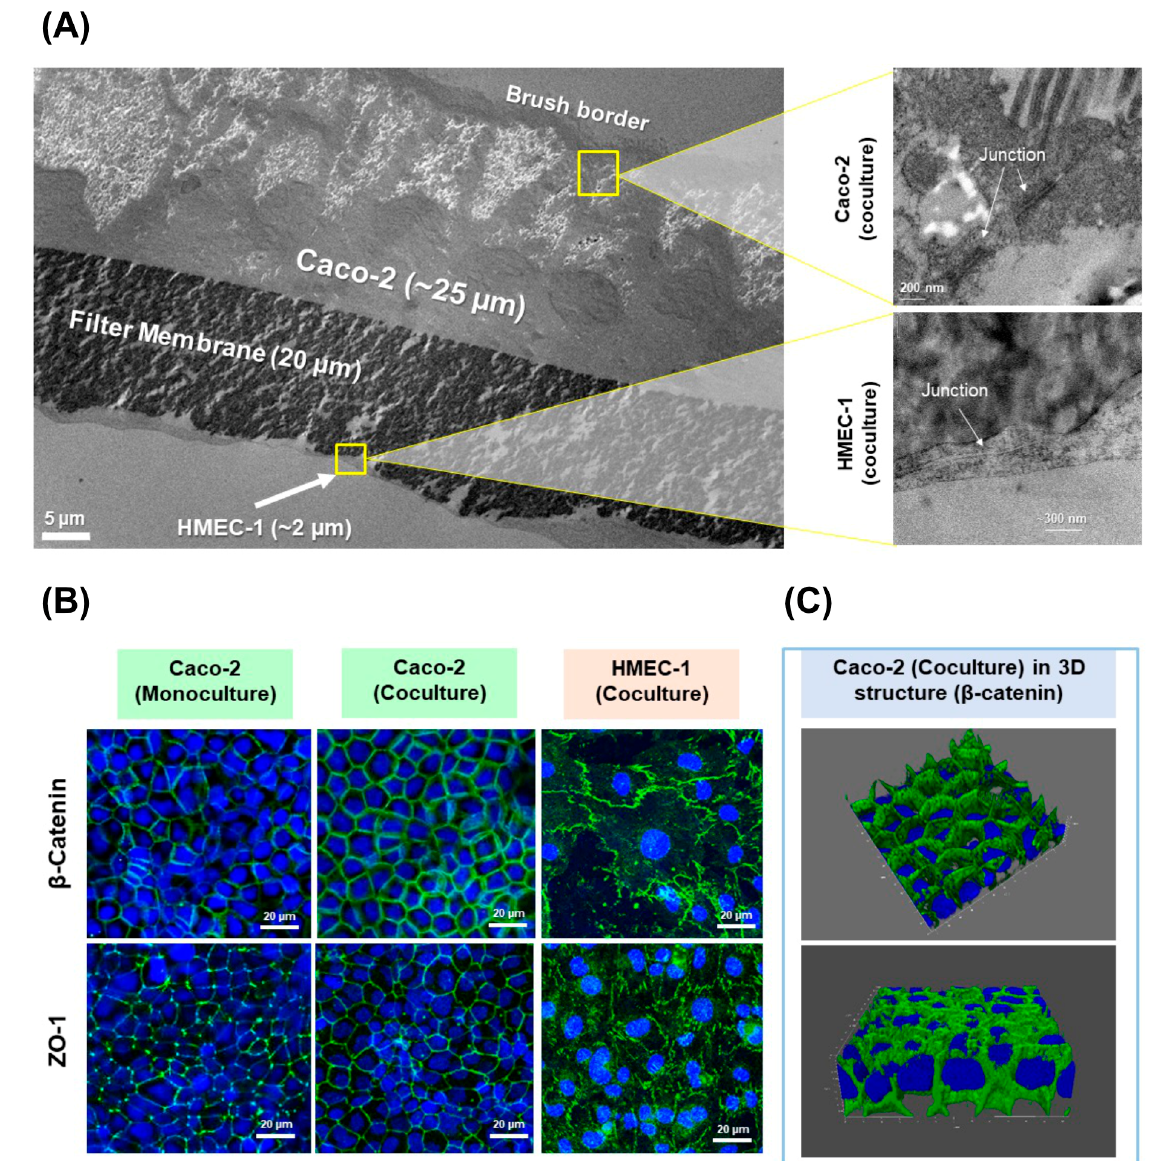
Figure 1. ( A ) Cross-sectioning images of Caco-2 and HMEC-1 coculture layers under TEM (left) and zoomed cross-sectioning images of the junction area between Caco-2 cells (upper right) and HMEC-1 cells (lower right); ( B ) immunofluorescent staining images of Caco-2 monoculture, cocultured Caco-2 and cocultured HMEC-1 layers, characterized by confocal microscopy for the expression of tight junction protein ZO-1 (Alexa Fluor ® 488, green) and adherens junction protein β -catenin (Alexa Fluor ® 488, green). The images are overlayed with cell nuclei (DAPI, blue); ( C ) the 3D images show only the expression of β -catenin in the cocultured Caco-2 layer and revealed a confluent monolayer with no cell stacking.